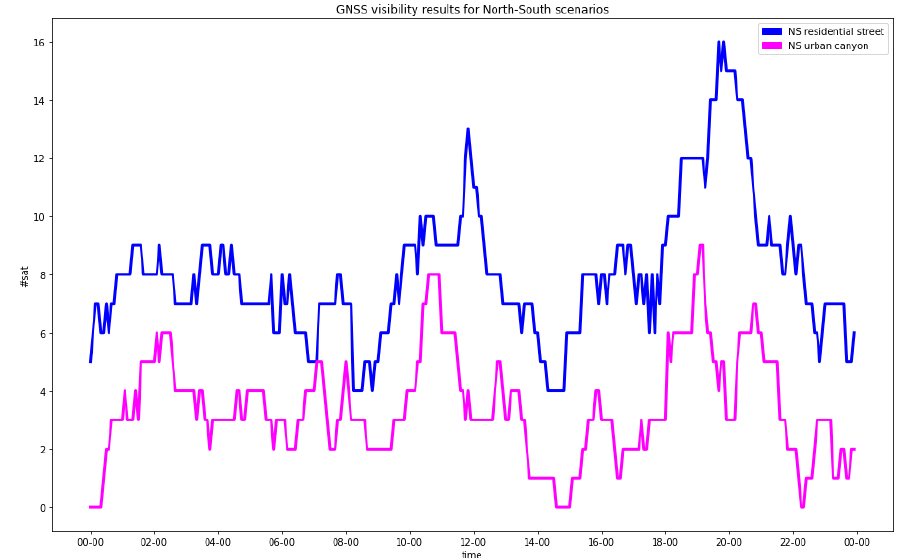
Figure 4. GNSS visibility for north-south streets (blue = RA; pink =